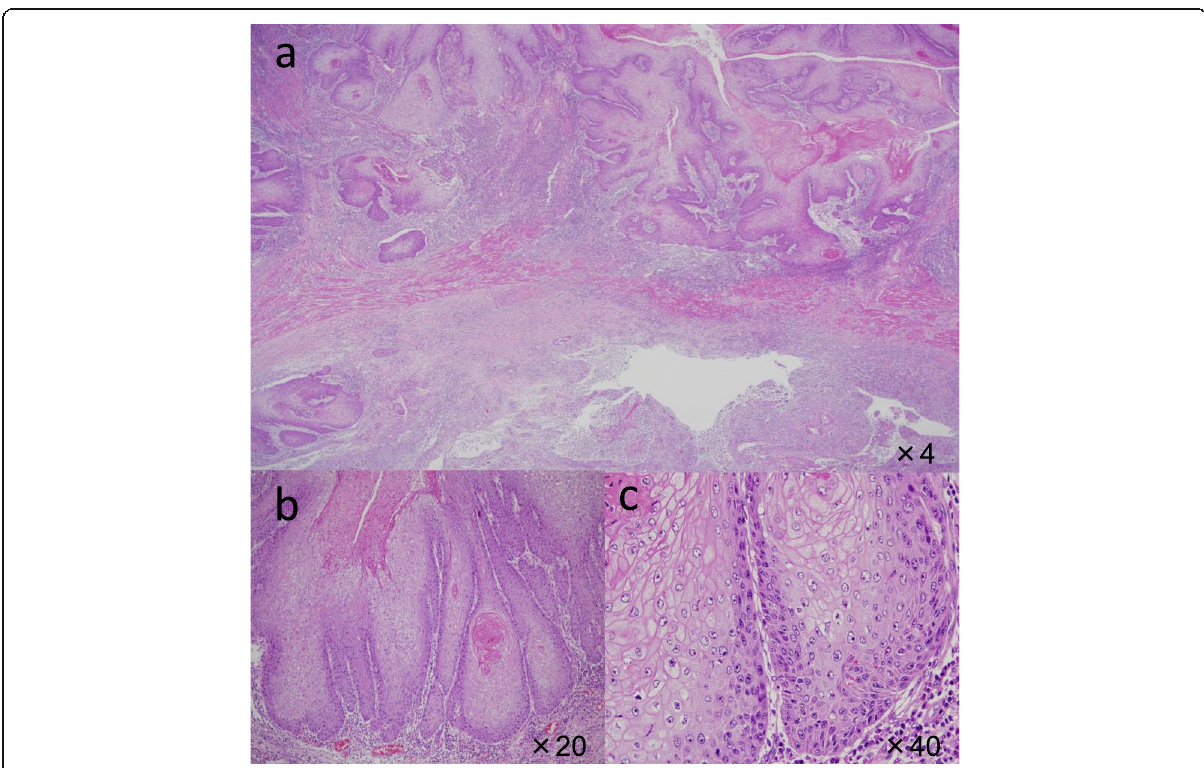
Fig. 7 Microscopic findings of the tumor. a Microscopic findings showed epithelial downgrowth and invasive findings and diagnosed as well- differentiated squamous cell carcinoma. b , c Focal hyperkeratosis with a church spire configuration was